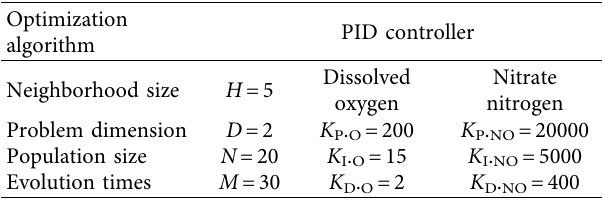
Table 3: Parameter settings.